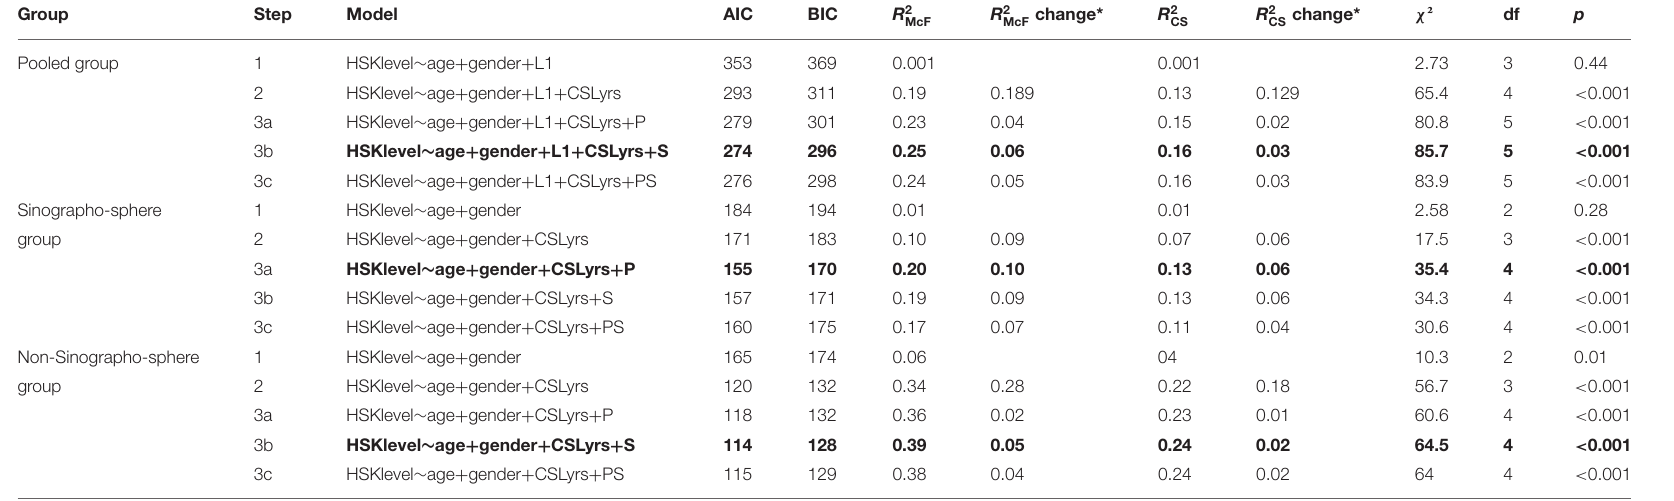
TABLE 9 | Summary of results for ordinal regression tests.